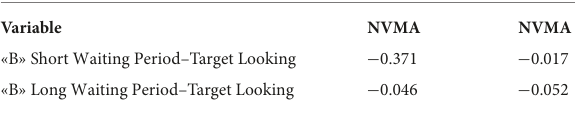
TABLE 2 Correlations between non-verbal mental age (NVMA) and looking durations for “B” trial with short and long waiting period for both